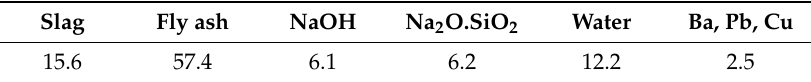
Table 2. Composition of matrices (wt